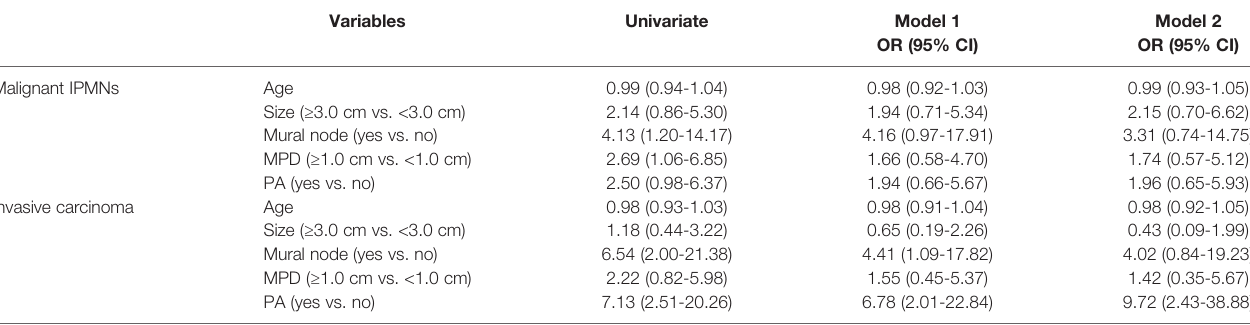
Model 2 was additionally adjusted for diabetes and tumor location. Malignant IPMNs: high grade and invasive carcinoma. MPD, main pancreatic duct; PA, pancreatic atrophy; CI, con fi dence interval; OR, odds